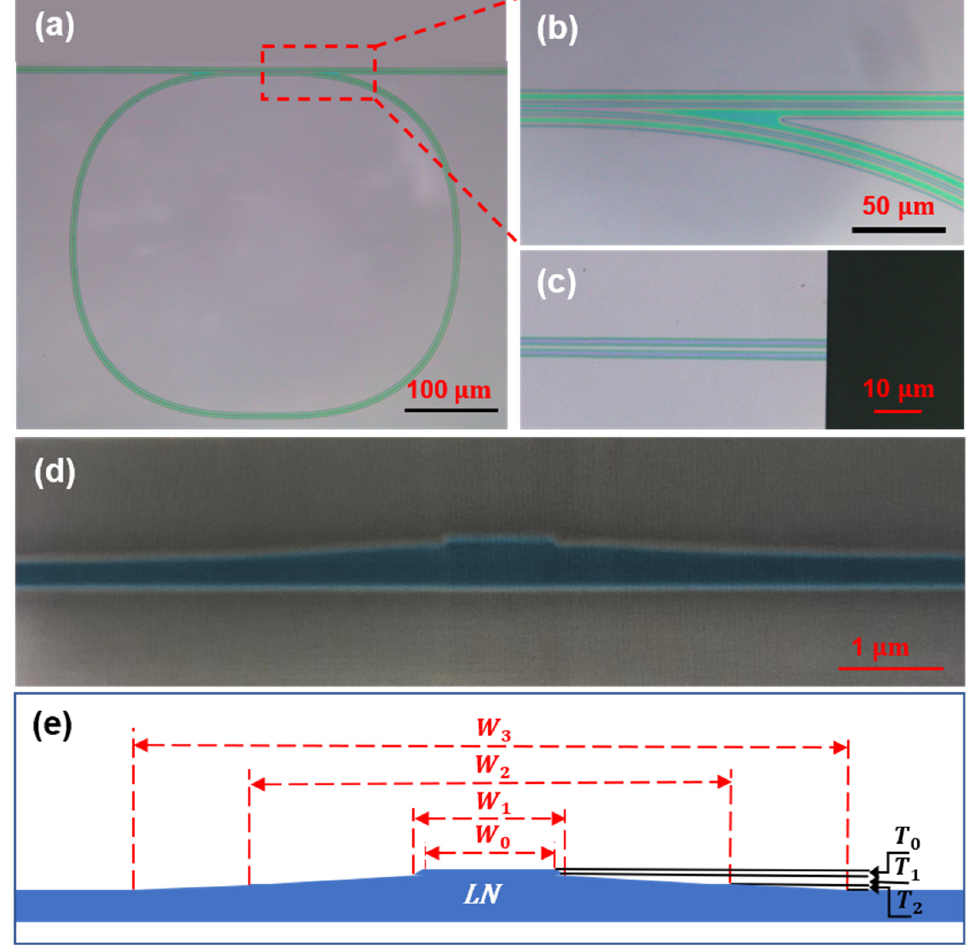
Figure 2. ( a ) Microscope image of the proposed LN microring. ( b ) Close-up of half of the coupling region. ( c ) Close-up of the end facet of the waveguide. ( d ) The false color scanning electron microscope (SEM) images of the cross-section of the waveguide and microring. ( e ) Illustration schematic of ridge waveguide structure on TFLN fabricated by PLACE technique.